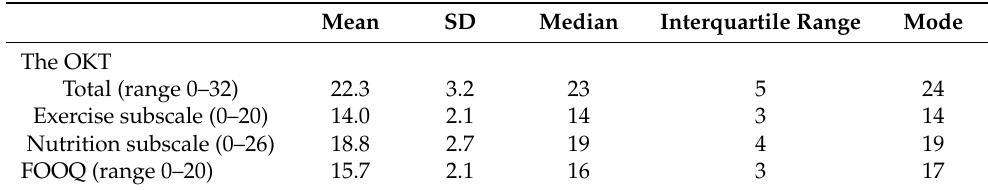
Table 2. Knowledge of osteoporosis among public health workers. Mean